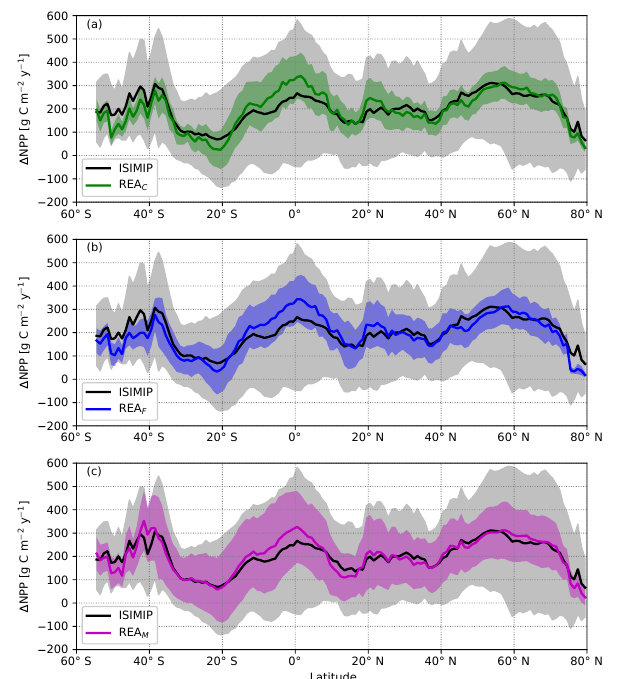
Figure 1. Zonal mean (cid:49) NPP by the end of the 21st century (av- eraged over 2095–2099) under RCP8.5 compared to the end of the historical simulations (averaged over 2001–2005). Shading repre- sents the uncertainty around the zonal mean across the ISIMIP en- semble, taken as 1 SD for ISIMIP, and calculated following Eq. (4) for REA. REA C , REA F and REA M refer to REA values calculated based on observationally constrained CARDAMOM, FLUXCOM and MODIS NPP,